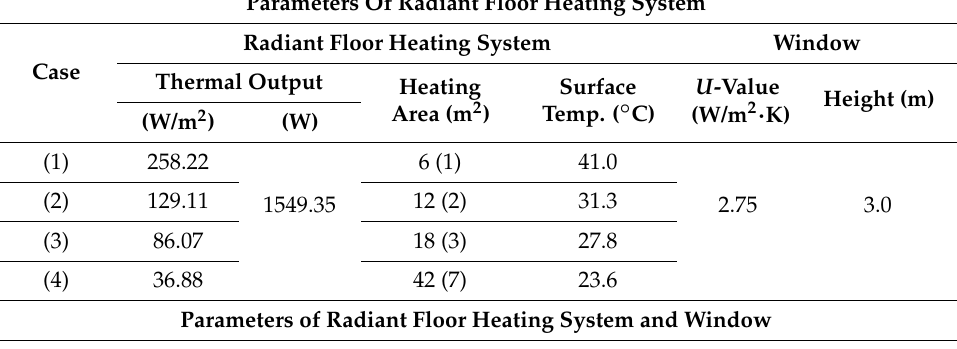
Table 4. Configuration of the simulation